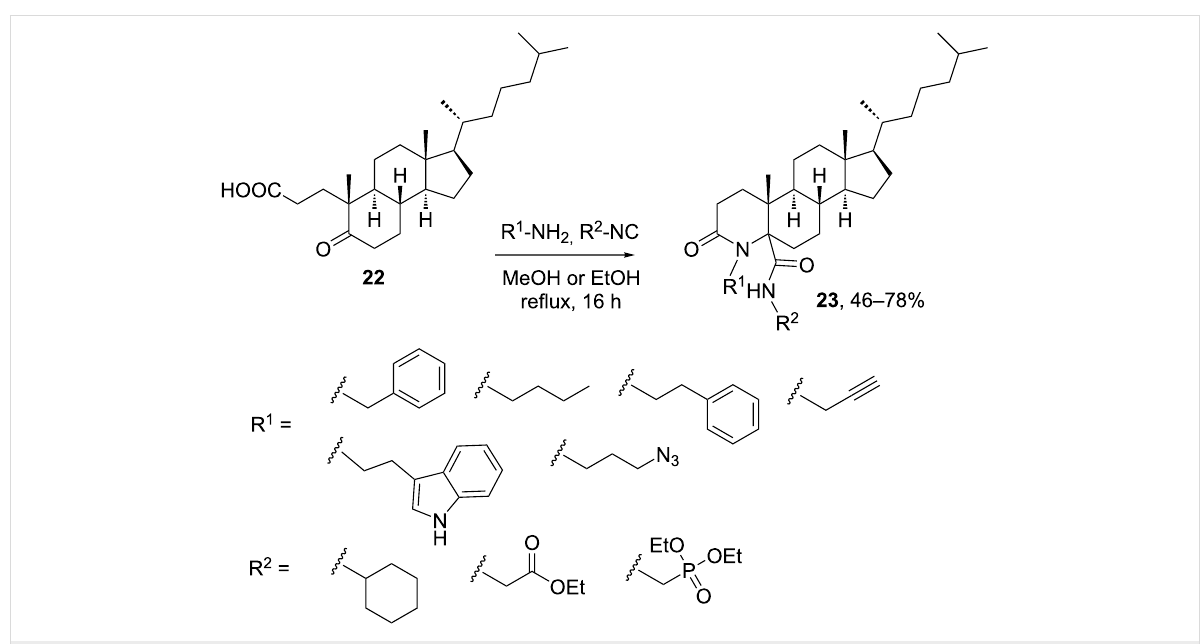
Scheme 6: Synthesis of 4-azacholestanes by an intramolecular Ugi-4C-3R